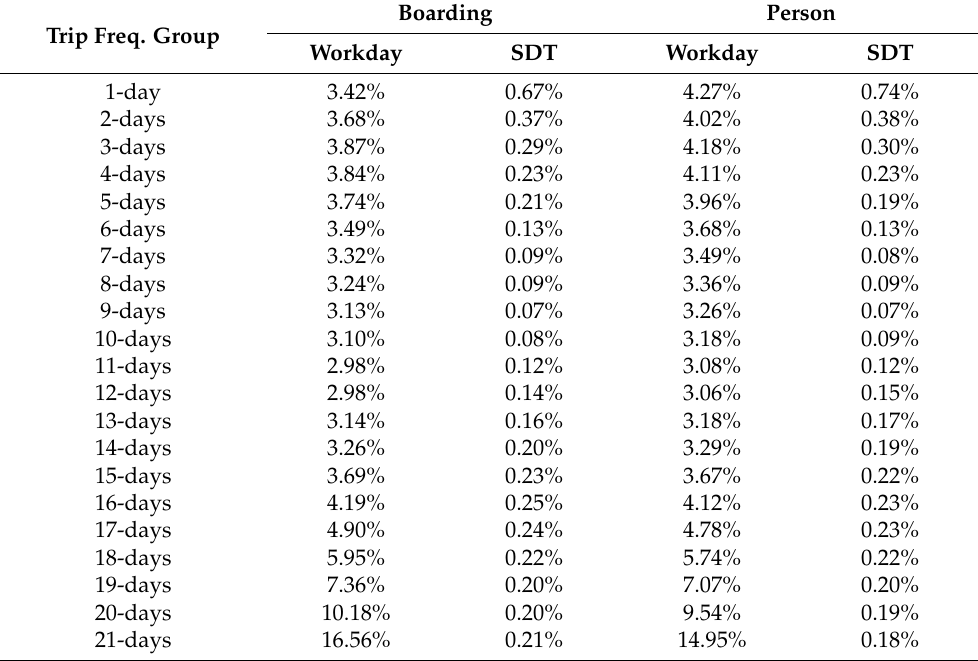
Table 4. Workday analysis: number of boarding and users. Boarding Person Trip Freq. Group Workday SDT